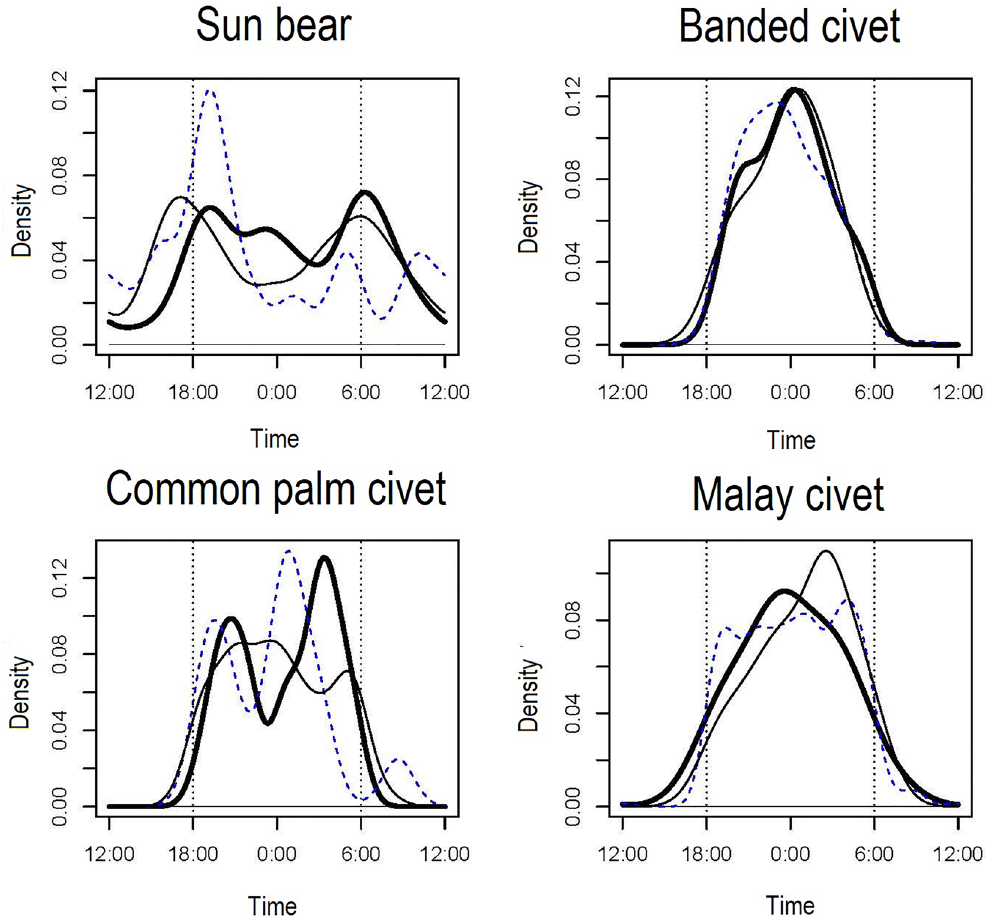
Figure 1. Overlaps of activity patterns of the four carnivore species among the three study sites. Dotted line, solid line, and thick line indicate kernel density estimations in DVCA, LKWS, and TWR, respectively. Dotted vertical lines indicate approximate times of sunset and sunrise, and short vertical lines under the kernel density curves indicate photo-captured times of each